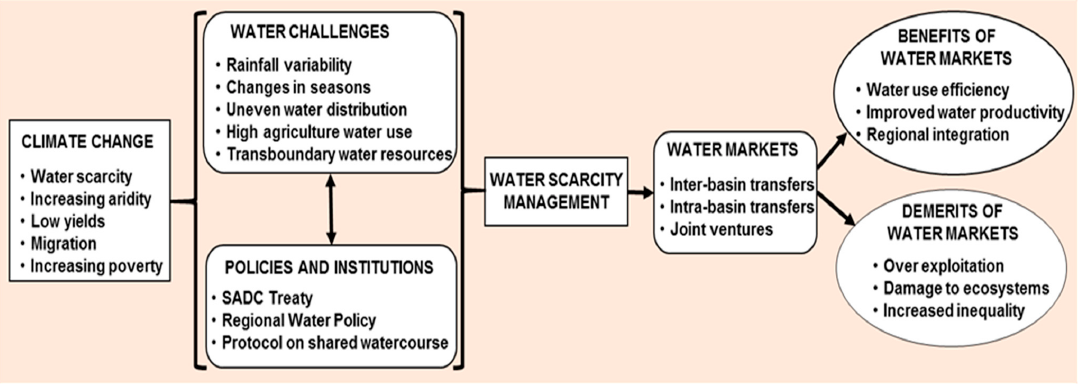
Figure 2. Methodological framework used in this study. Source: Developed by authors.